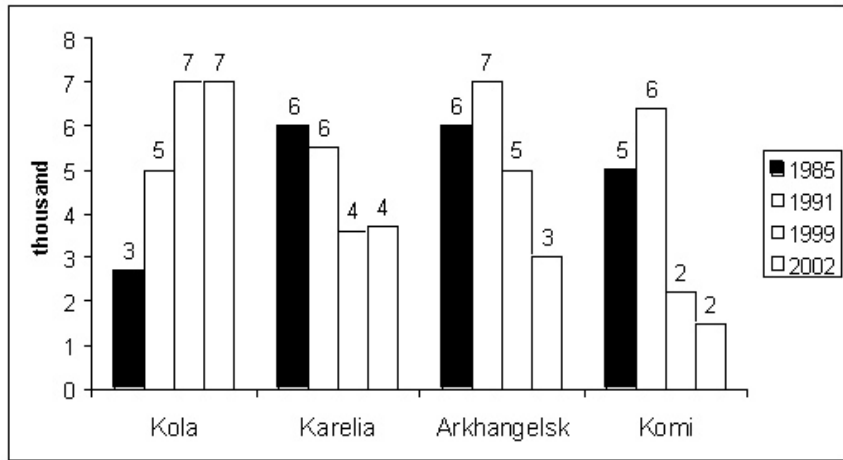
Fig. 1. Wild reindeer numbers in European Russia regions (Makarova & Khokhlov, 1985; Novikov, 1996a; Paponov, 2000; Ermolaev et al. , 2003; Korepanov et al .,